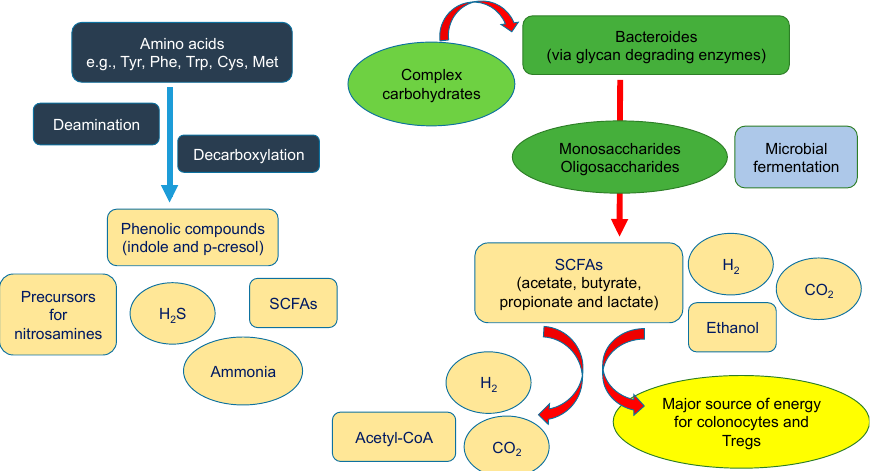
Figure 1. Metabolism of amino acids and carbohydrates by gut microbiota. Complex carbohydrates are converted to monosaccharides and oligosaccharides, and then fermented to hydrogen (H 2 ), carbon dioxide (CO 2 ), ethanol, and short-chain fatty acids (SCFAs). SCFAs serve as a major source of energy for colonocytes and regulatory T lymphocytes (Tregs), or are converted to acetyl coenzyme-A (Acetyl-CoA), H 2 , and CO 2 . The deamination and decarboxylation of amino acids leads to the formation of ammonia, SCFAs, phenolic compounds, nitrosamines and hydrogen sulfide (H 2 S).